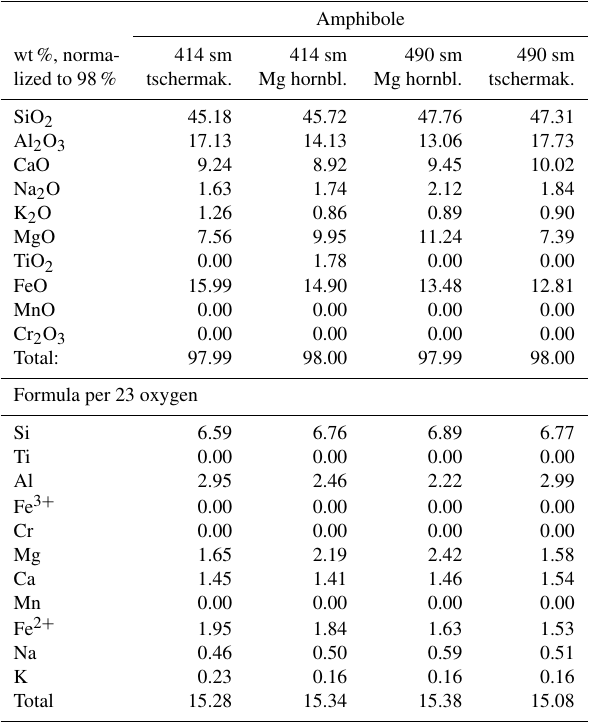
Table 3. EDS measurements of Amp chemical compositions from samples deformed at Pc ≈ 1 .